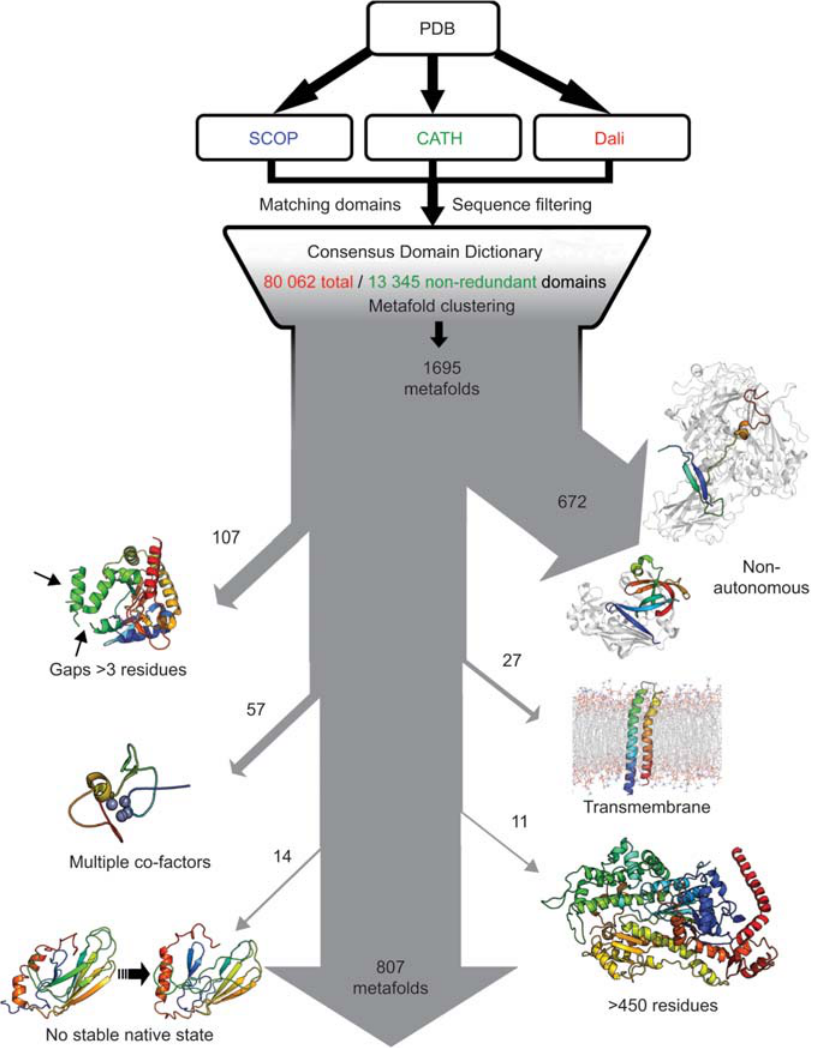
Figure 1 Selection of autonomous fold representatives for